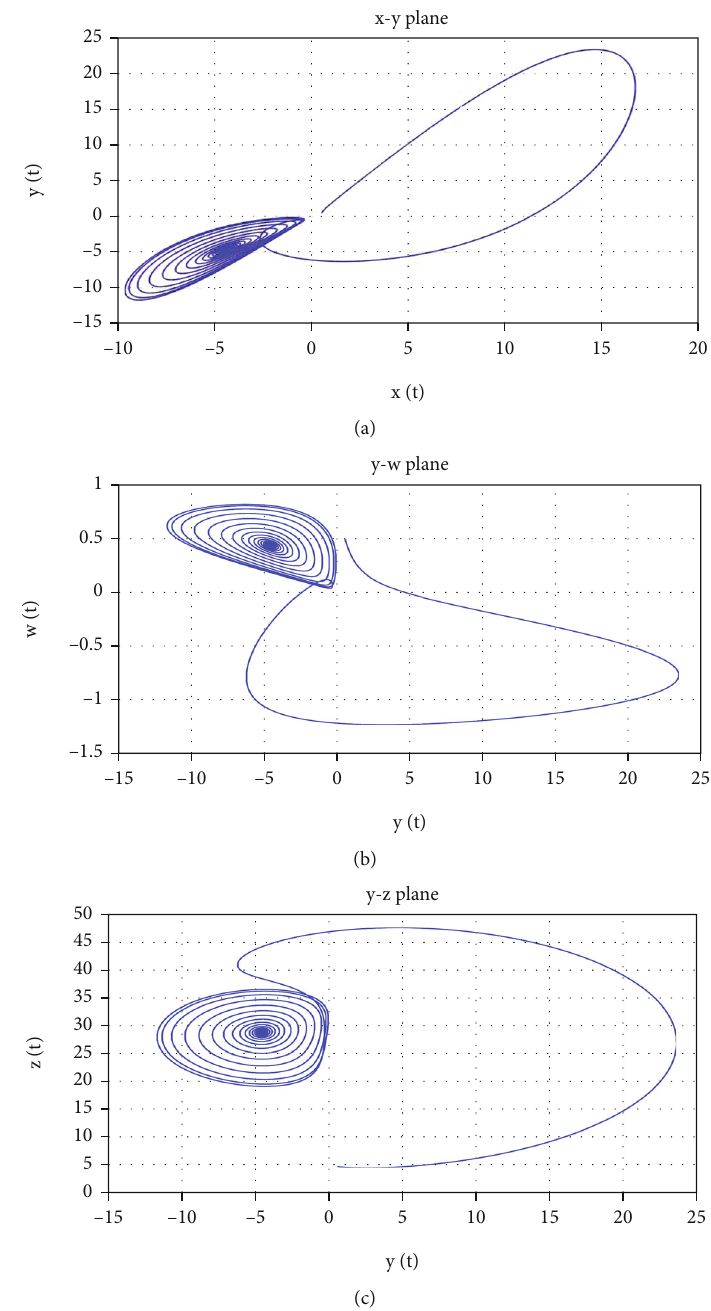
Figure 2: Phase portraits of (5) for η = 0 : 950 projected on three planes: (a) x - y , (b) y - w , and (c) y - z